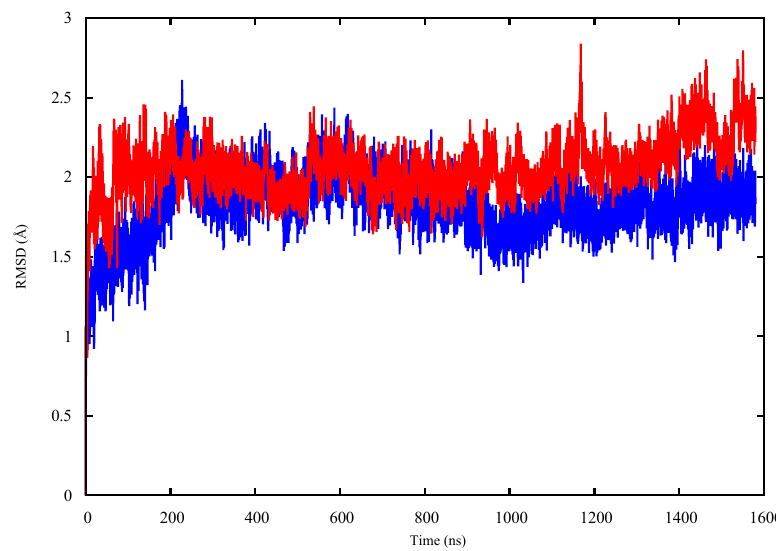
Figure 4. A plot of the RMSD of monomers B of the p53-dimer in complex with DNA; wt-p53 (blue), G245S-mp53 (red).